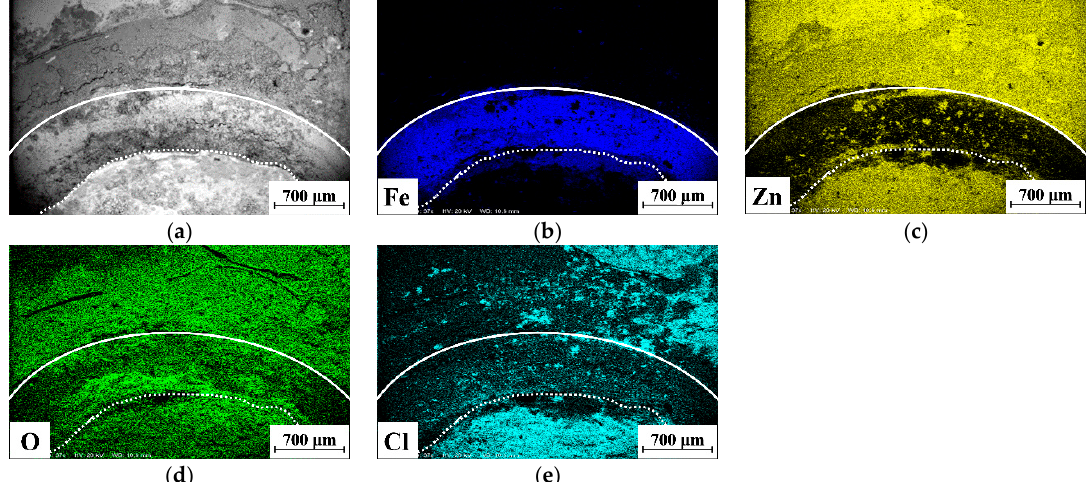
Figure 10. ( a ) SEM micrograph (BSE mode) on weld spot surface and surrounding HAZ of sample no. 2 after the salt spray exposure test. Chemical distribution of elements ( b ) Fe, ( c ) Zn, ( d ) O, and ( e ) Cl, as obtained from EDS analysis. White dotted lines point out the border of the fractured spot weld on the sheet (top line) and on the pull out head (bottom line). The continuous line defines the border of the sheet surface without the zinc layer.